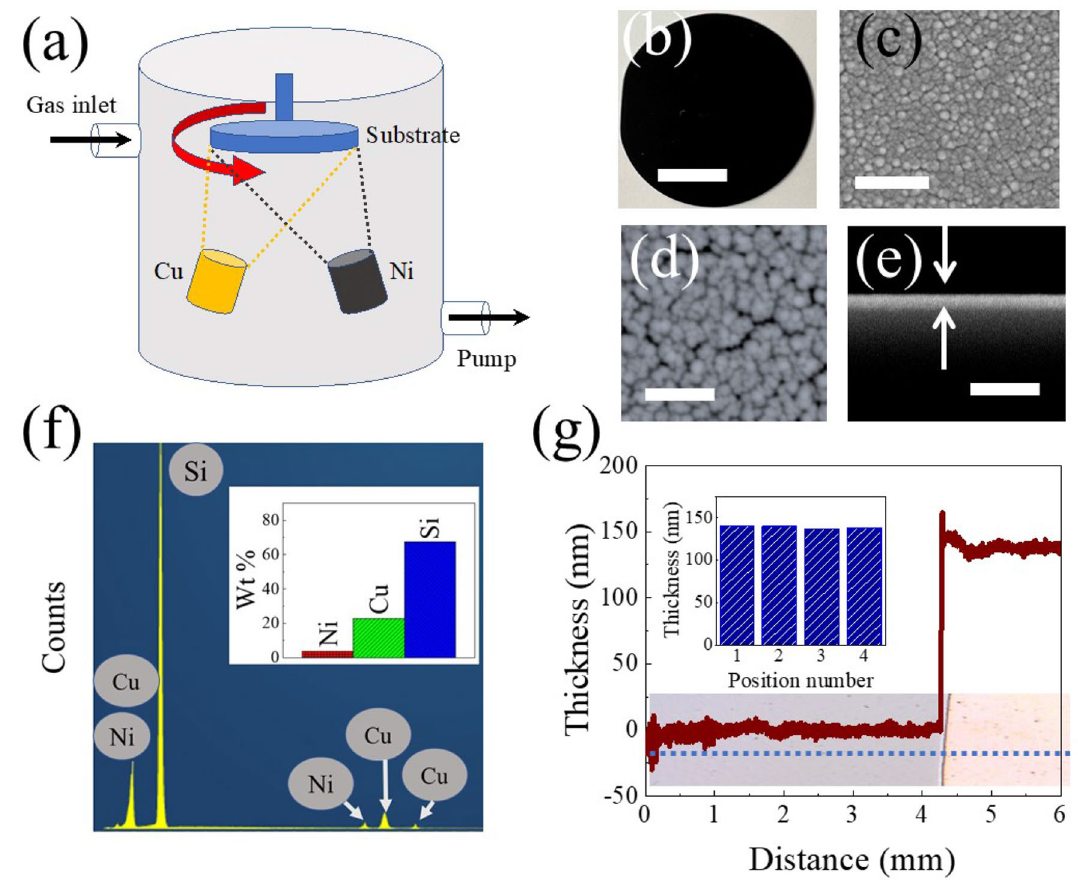
Figure 1. Characterization of Cu–Ni thin film: ( a ) Schematic illustration of the sputtering deposition chamber, ( b ) optical image of thin film deposited on the wafer (scale bar is 2 cm), ( c , d ) SEM micrographs of Cu–Ni thin film with a scale bar on the image ( c ) is 200 nm and on the image ( d ) is 100 nm, ( e ) cross-sectional SEM micrograph of Cu–Ni thin film with sale bar 1 µm, ( f ) EDS spectrum of Cu–Ni thin film with inset displays wt% of elements from EDS results, and ( g ) thickness profile of Cu–Ni thin film and bar graph in the inset provides the thickness of Cu–Ni thin film measured at various positions on the thin in superior performance. When Cu and Ni work synergistically for glucose sensing, multiple electrochemical reactions occur simultaneously 37 . A schematic illustration for electrocatalysis of Cu–Ni thin film electrode for glucose oxidation is displayed in Fig. 2c. Initially, Cu and Ni atoms are oxidized and then participate in glucose oxidation reactions as expressed in reaction (1) and (2) 37 .